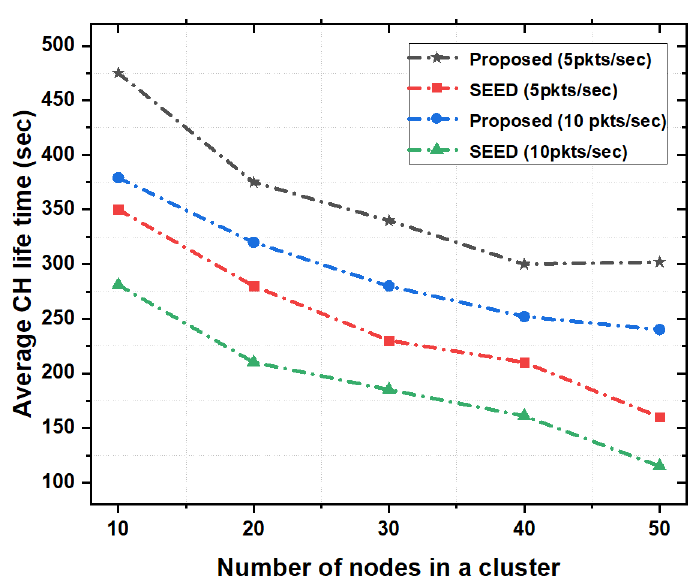
Figure 5. Average CH lifetime as a function of the number of nodes in a